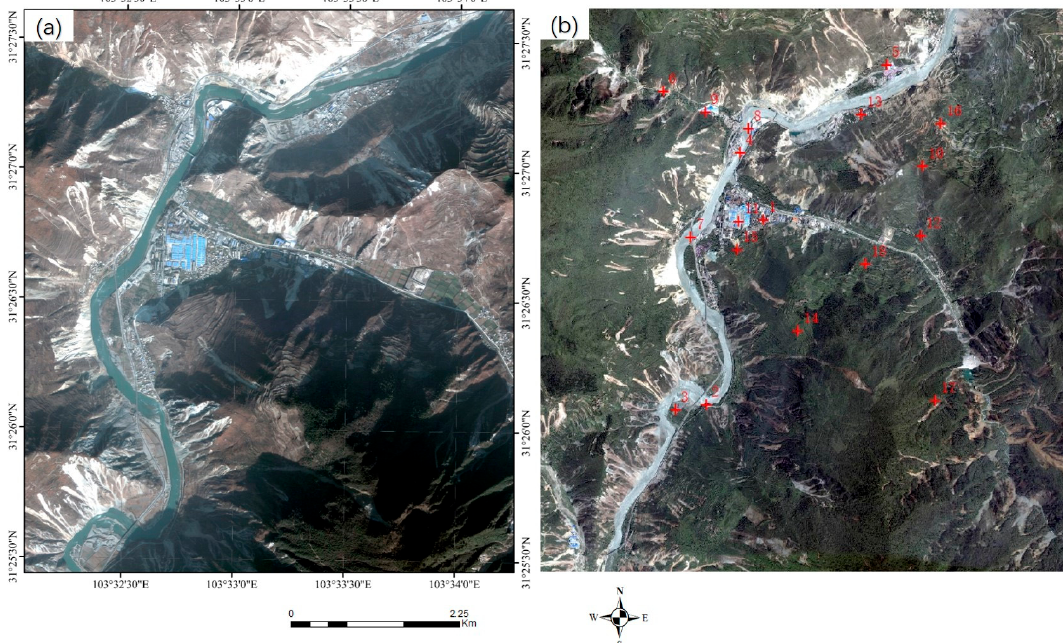
Table 2. Details of the three image datasets used in the experiment.